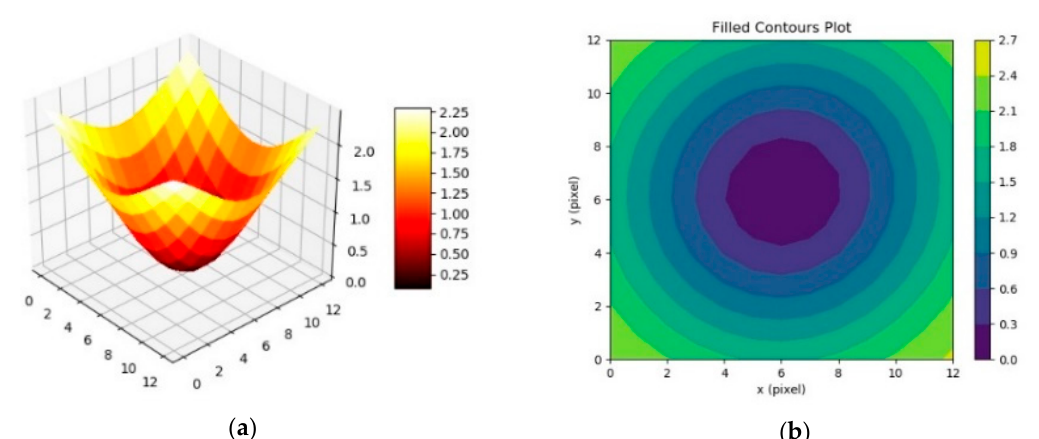
Figure 11. ( a ) 3D surface obtained by plotting the matrix of the sum of the variances. ( b ) Contours plot of the 2D projection of the same matrix.